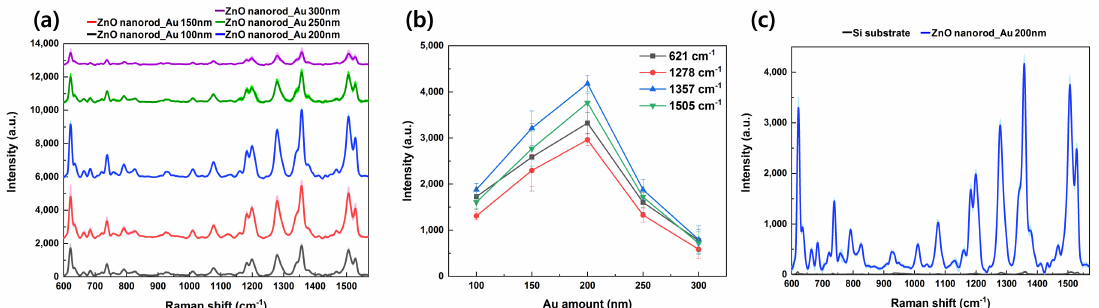
Figure 3. ( a ) SERS spectra and standard deviation (pastel-colored area) of 1 mM Rh B on Au-deposited ZnO nanorods with gold thicknesses of 100 (black curve), 150 (red curve), 200 (blue curve), 250 (green curve), and 300 nm (purple curve). ( b ) Intensity of SERS peaks as a function of the thickness of Au. ( c ) Comparison spectrum of the SERS effect with equivalent illumination power for Rh B on Si substrate (black curve) and on ZnO nanorod substrate deposited with 200 nm gold (blue curve), with standard deviation shown